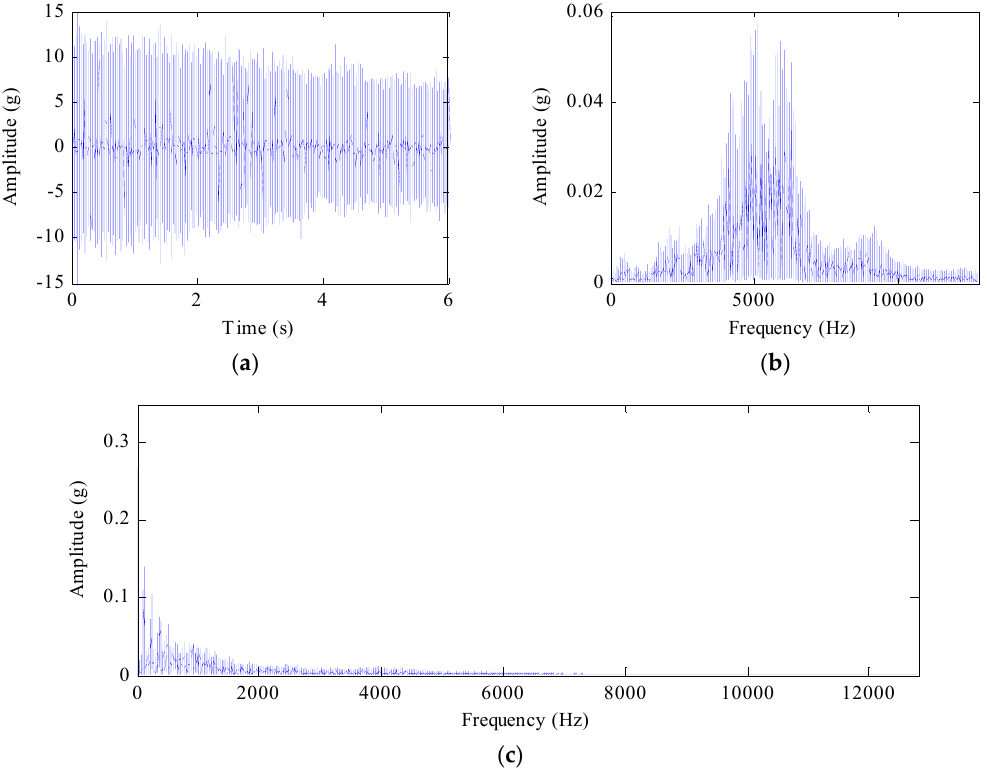
Figure 11. ( a ) Original vibration signal of the bearing in time domain; ( b ) the frequency of the vibration signal in frequency domain; ( c ) the envelope spectrum of the original signal. signal in frequency domain; ( c ) the envelope spectrum of the original